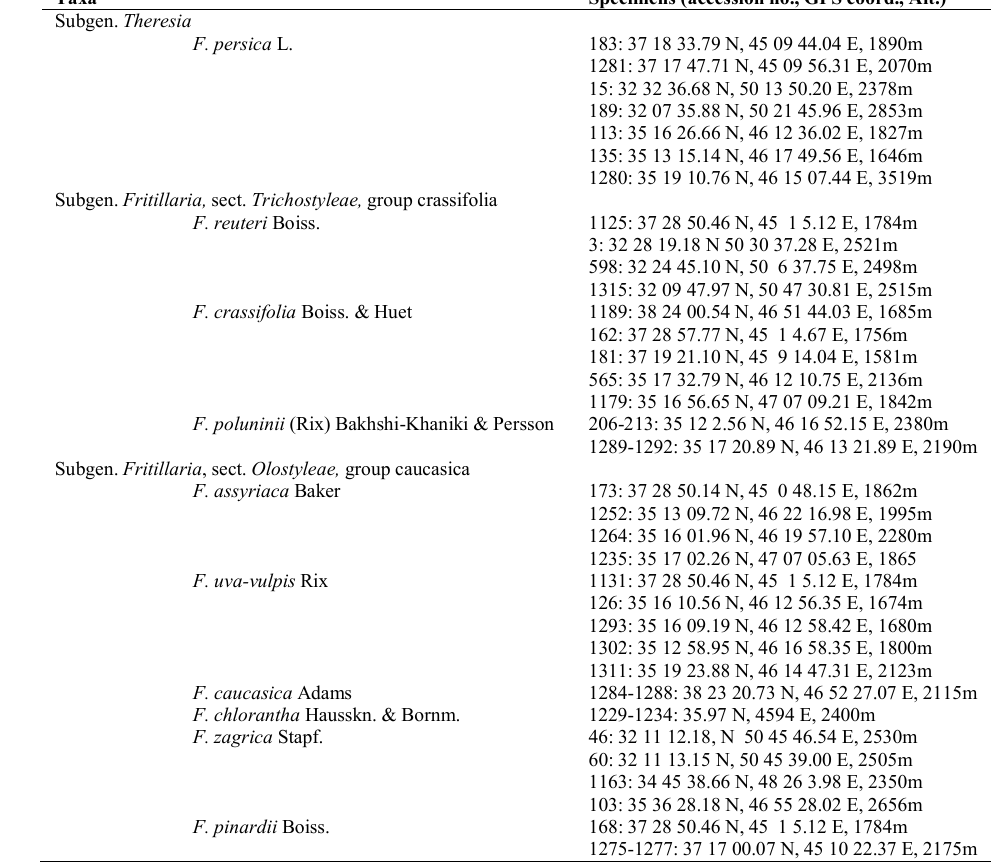
Table 1. Geographical information for species investigated in this study Taxa Specimens (accession no., GPS coord., Alt.) Subgen. Theresia F. persica L.